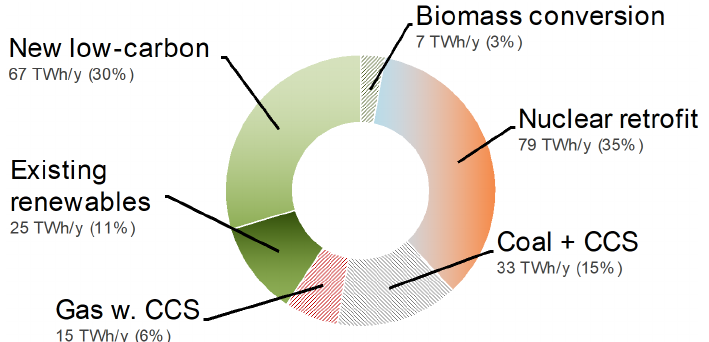
Figure 13. Possible future pathway for the decarbonized Polish power system (225